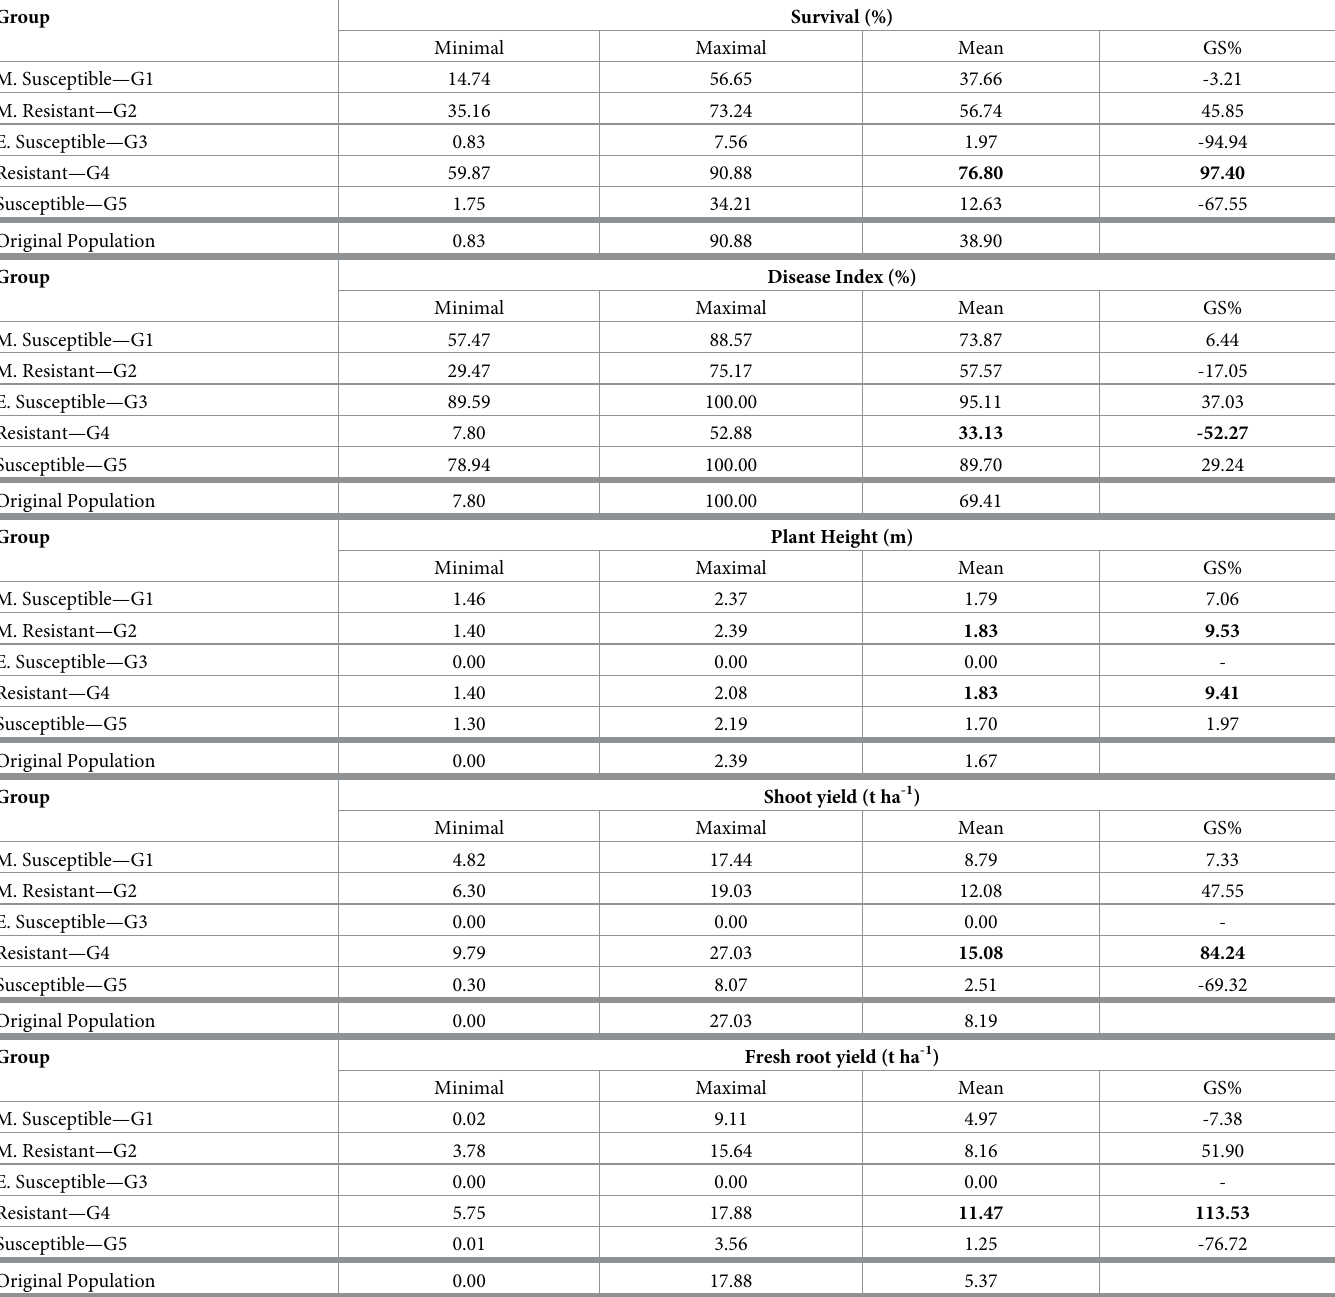
Table 1. Averages for survival, disease index, plant height, and shoot and fresh root yields for the groups formed by cluster analysis, with the expected selection gain (GS%) relative to the original population. Group Survival (%) Minimal